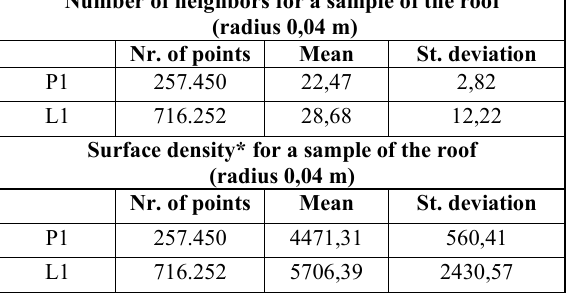
Table 8. Density analyses of the roof section. *number of neighbors (N) divided by the neighborhood